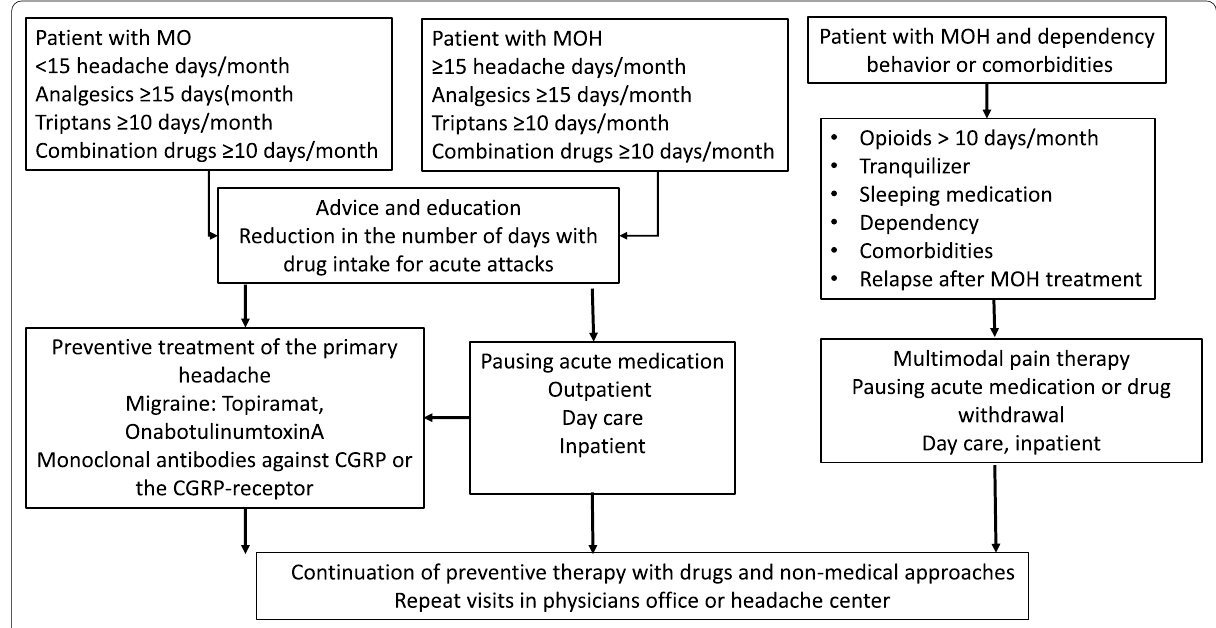
Fig. 1 Step care approach to the treatment of MO and